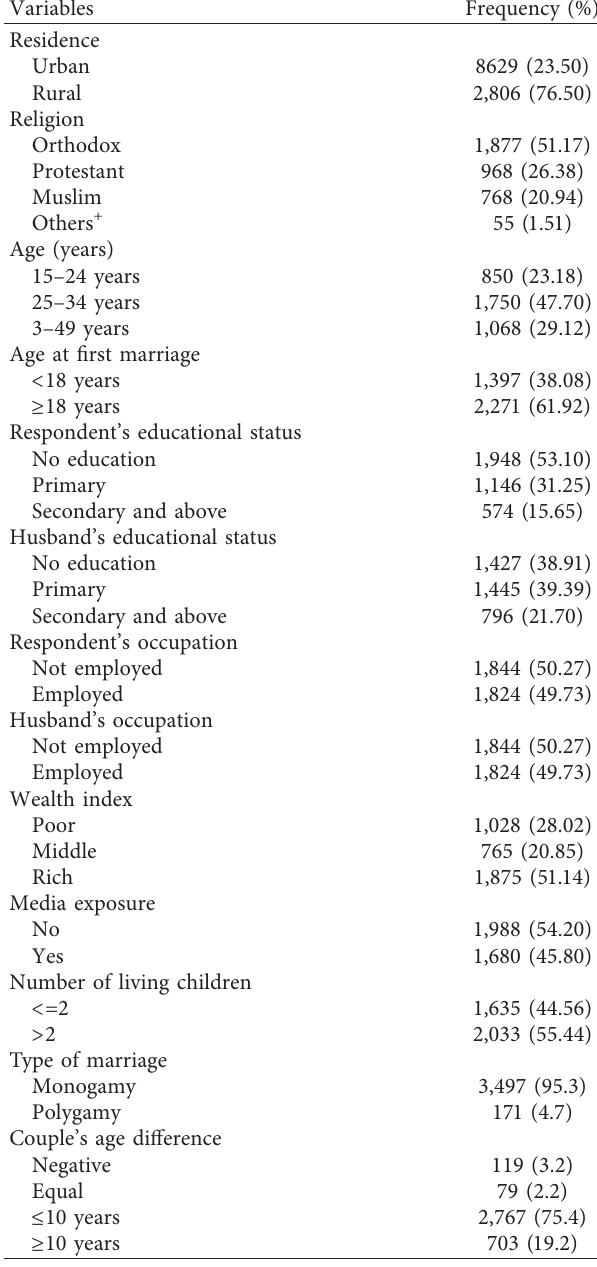
Table 1: Weighted sociodemographic characteristics of the study participants, Ethiopia,